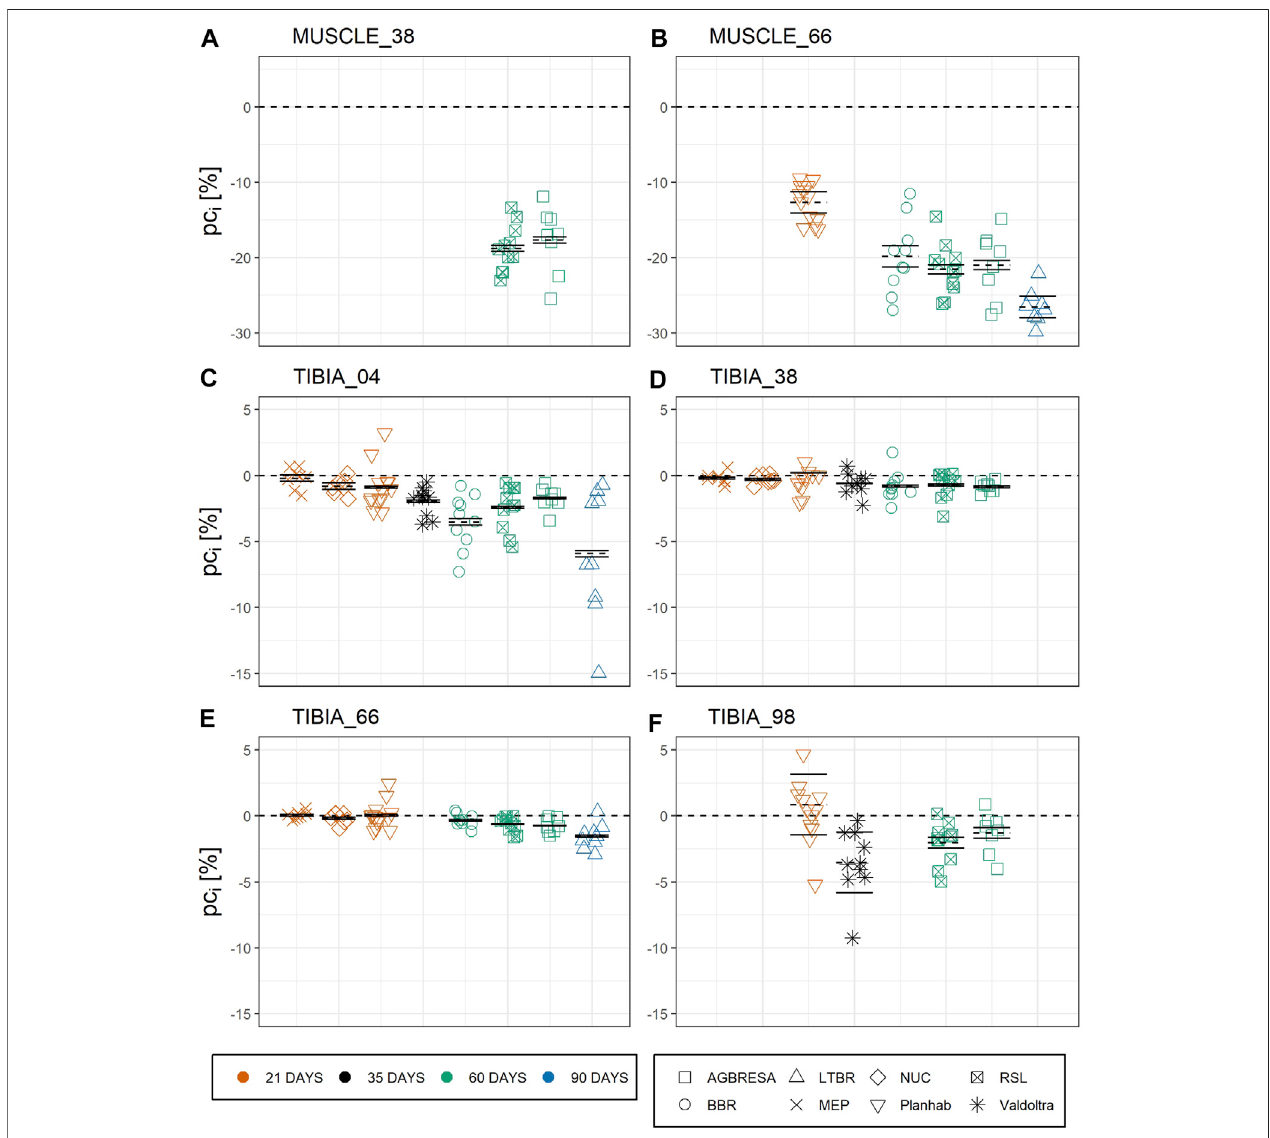
FIGURE 3 | Chart of the individual percent change ( pc i ) by measurement sites with (A) CSA at MUSCLE_38, (B) CSA at MUSCLE_66, (C) BMC at TIBIA_04, (D) BMC at TIBIA_38, (E) BMC at TIBIA_66, and (F) BMC at TIBIA_98, where the numbers indicate the relative measurement position regarding the entire tibia length from distaltoproximal.Thecolorindicatesthebedrestdurationandtheshaperepresentsthestudy.Eachchartisseparatedbythestudies,whoperformedmeasurementsat themeasurementsite.Meanofthepcasdashedline,upperandlowerlimitofthe95%-con fi denceintervalbasedonmeasurementuncertainty U Meas assolidlines. The vast majority of pc i exceeds the con fi dence interval indicating signi fi cant and substantial between-subject variation.